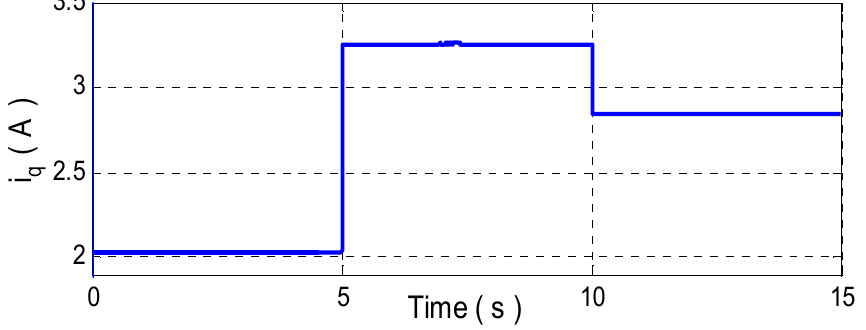
Figure 17. Current i q .